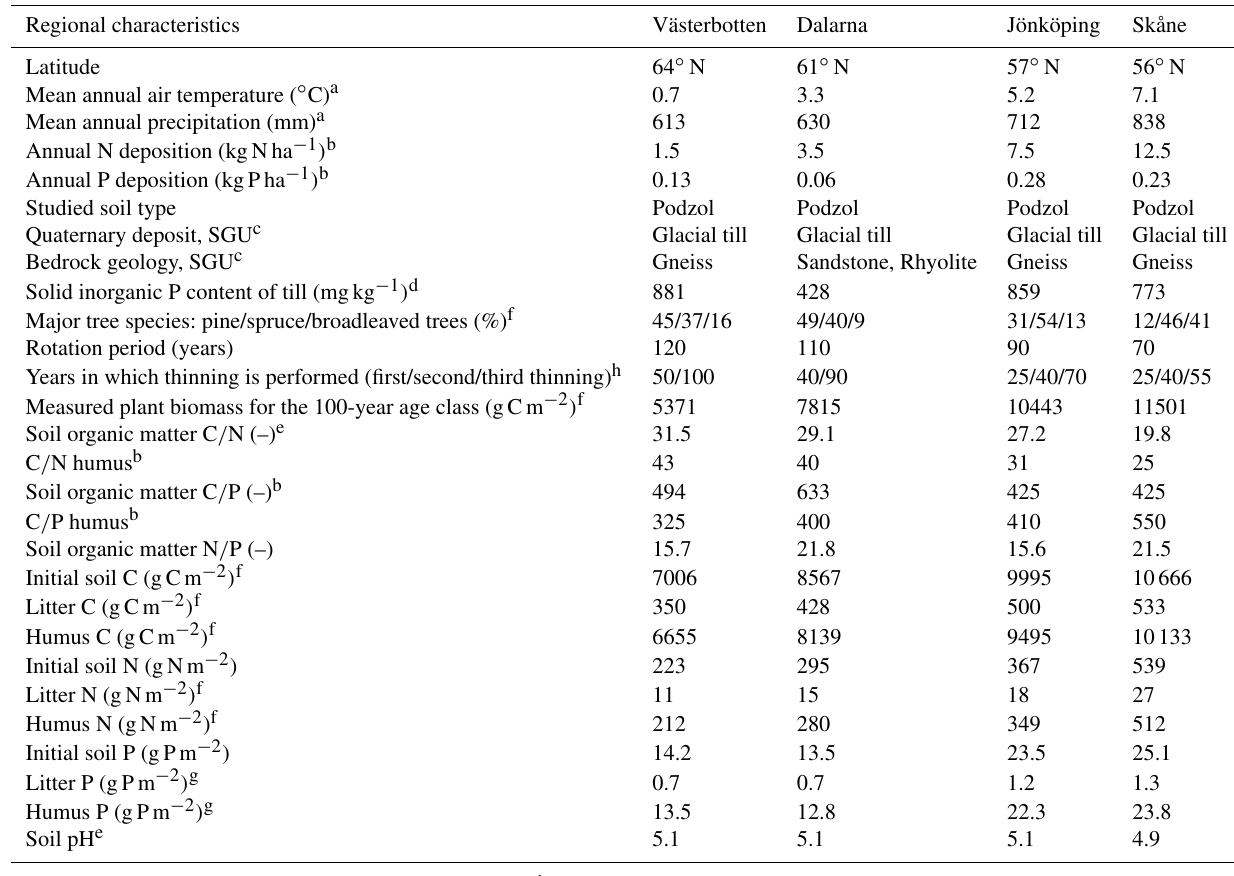
Table 1. Overview of climatic, geological, plant, and soil characteristics of the four forest regions. Regional